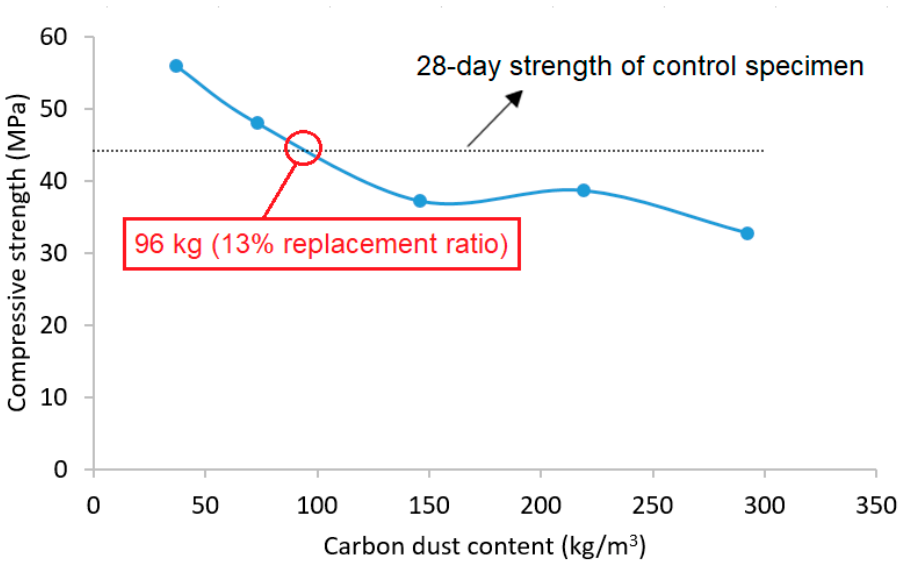
Figure 7. Carbon dust content versus compressive strength of mortar.